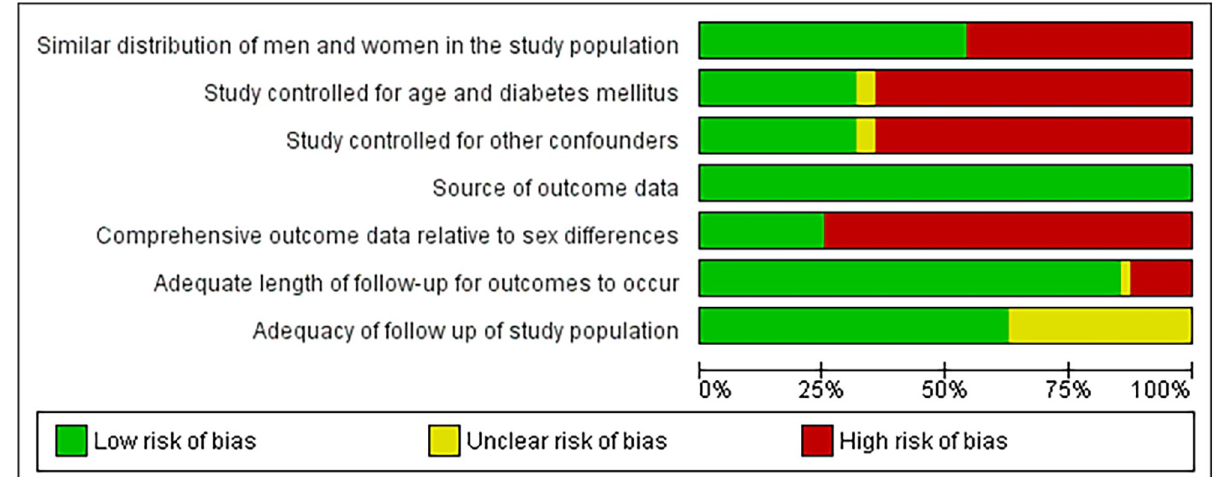
Fig 2. Risk of bias graph. Review authors’ judgements about each risk of bias item as presented as percentages across all included studies.